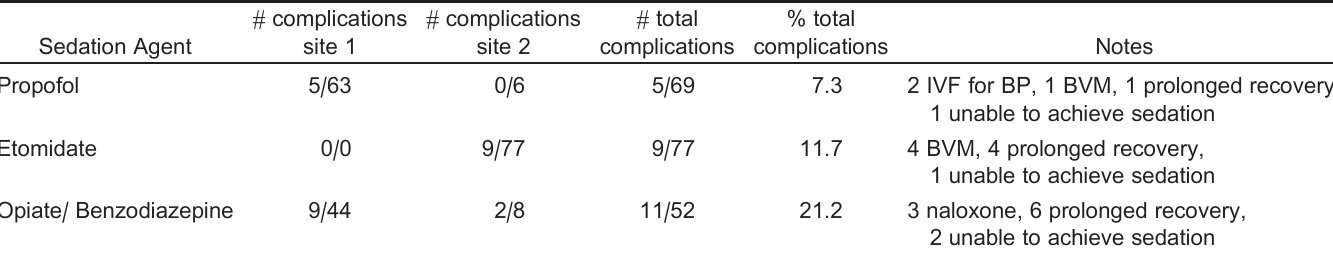
Table 3. Observed sedation complications.